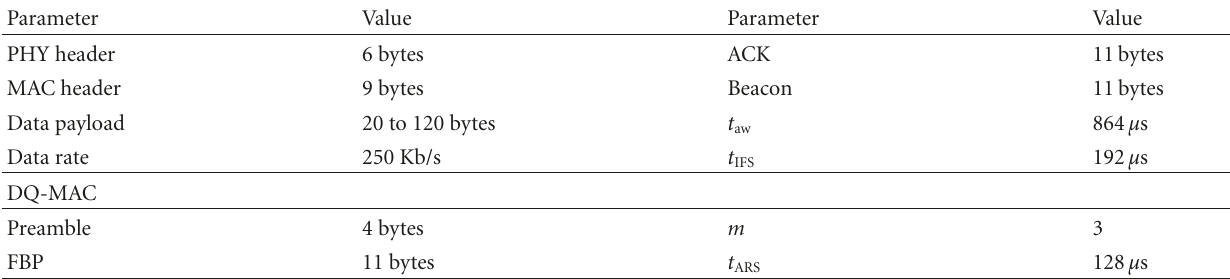
Table 1: IEEE 802.15.4 MAC parameter values.